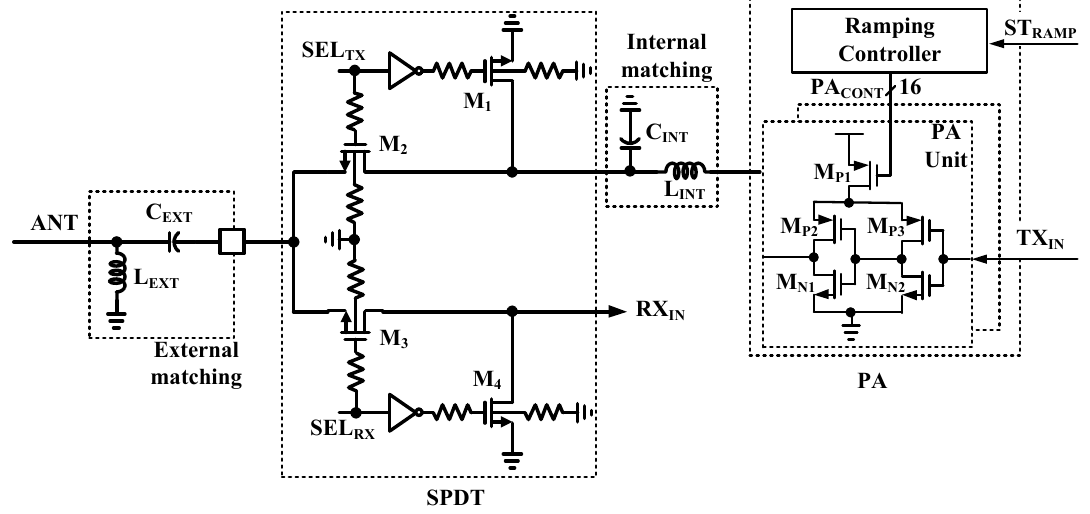
Figure 14. Block diagram of PA and SPDT.